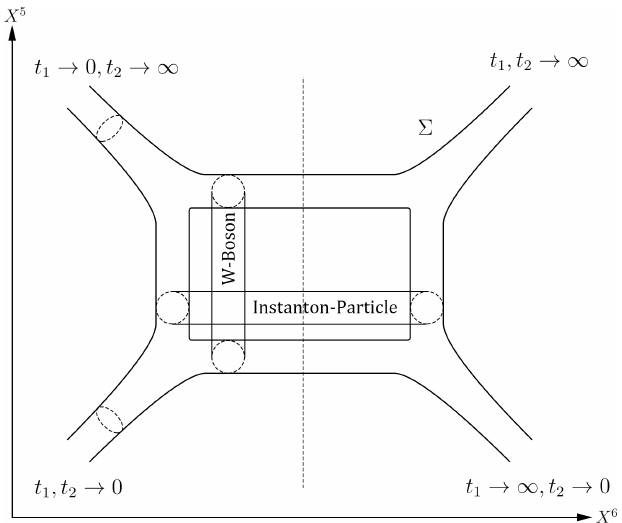
Figure 2 . The spectral curve Σ for SU(2) 0 theory. The M5-brane is wrapping the spectral curve Σ . The W-boson and instanton particle are M2-branes that end on a pair of 1-cycles on the spectral curve as shown in the figure. In the 5d limit, the circular direction of the spectral curve will close and it becomes the brane web for SU(2) 0